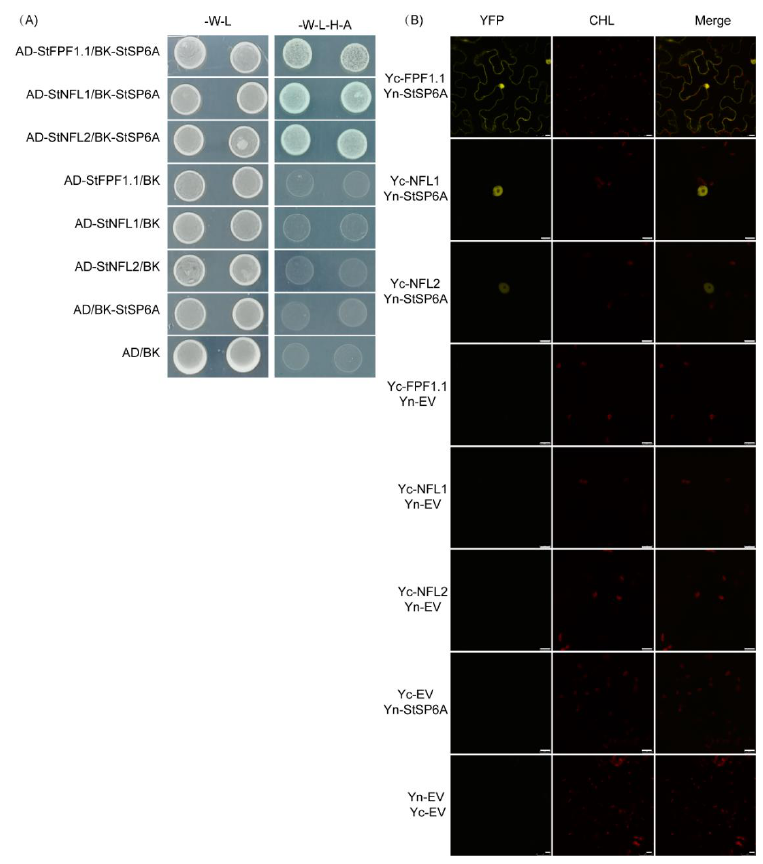
Figure 2. The interactions between the StSP6A and interactors in vivo and in vitro. ( A ) Yeast two- hybrid assays showing the interaction between StSP6A and the interactors. BK-StSP6A and pGADT7 (AD)-interactors were co-expressed in yeast on the double dropout (-Leu-Trp) medium and quadruple dropout medium with 20 mg/L X- α -gal. Empty vectors were used as negative con- trols. ( B ) BiFC assays to confirm the interaction between StSP6A and the interactors. The N. bentham- iana leaves were co-transfected with agrobacterium carrying the expression constructs for Yn- StSP6A and Yc-interactors. After 48 h, the YFP fluorescence signals were captured by a Leica TCS SP8 confocal microscope. The bar = 10 μm.